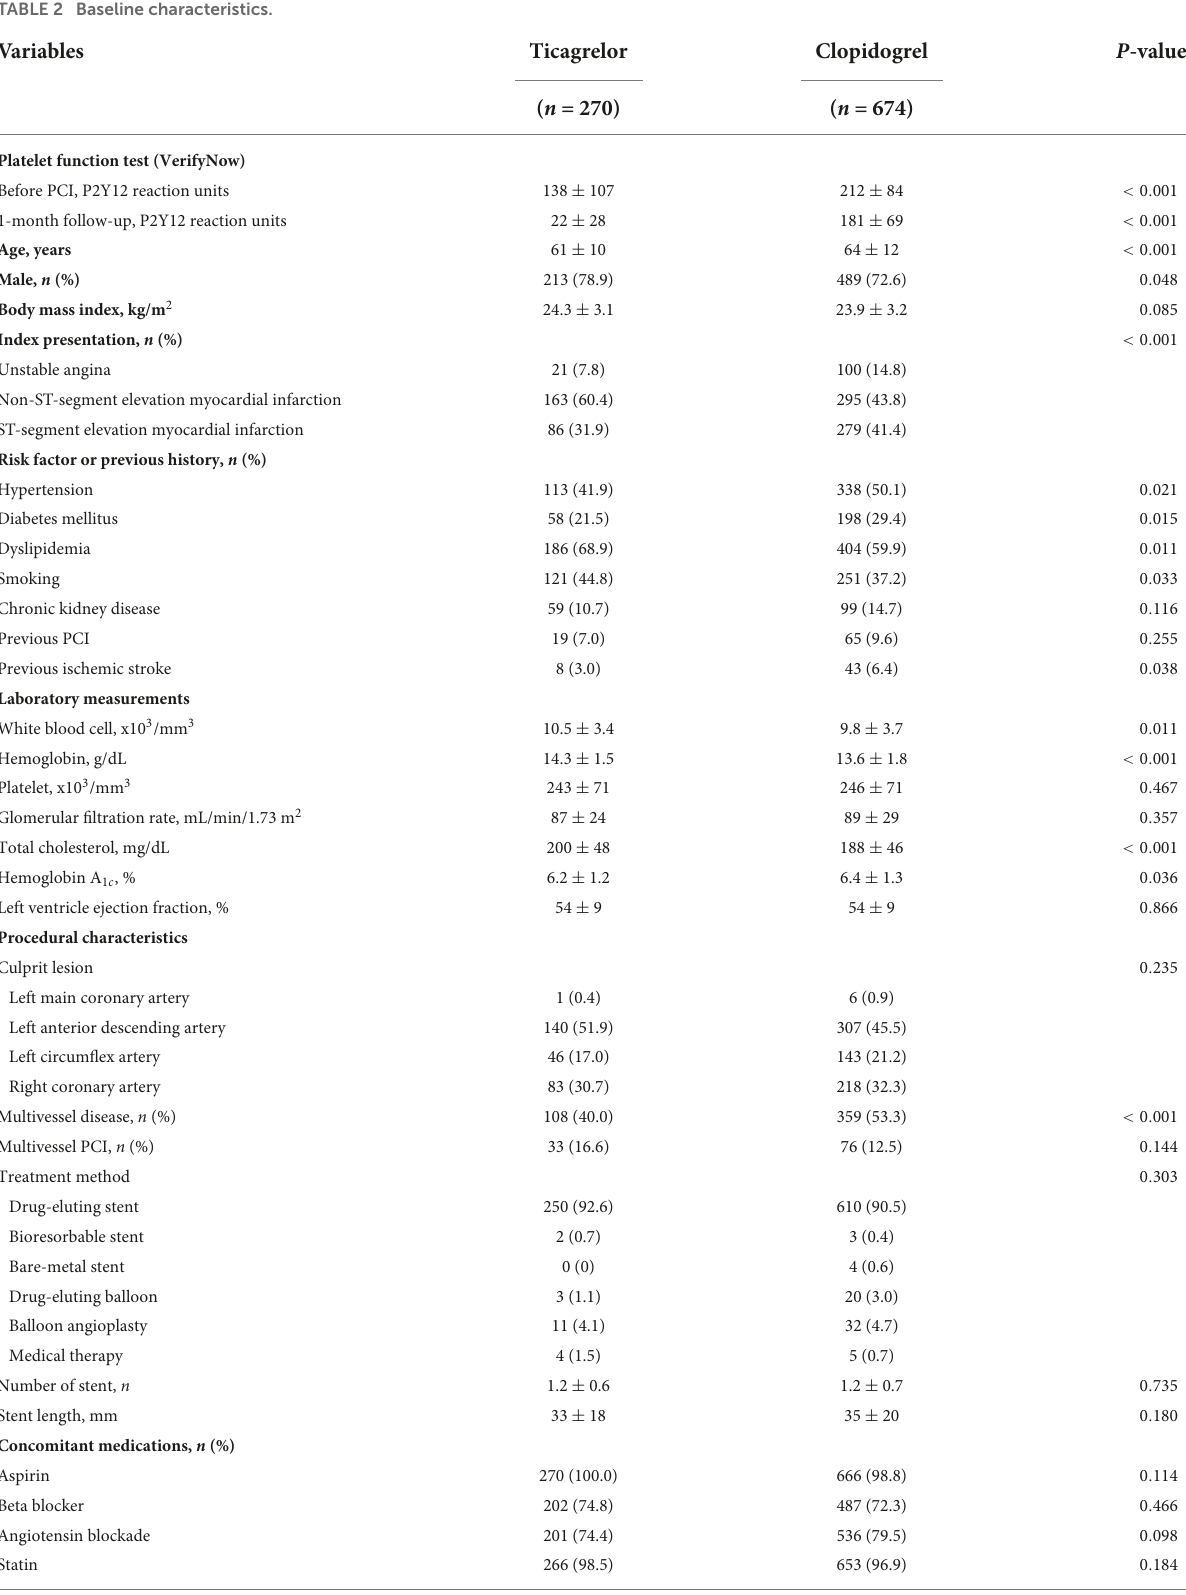
TABLE 2 Baseline